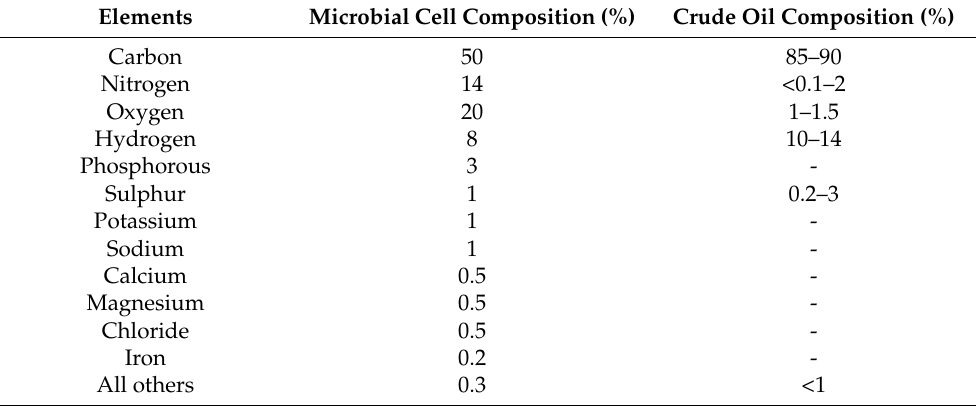
Table 3. Comparison for elemental composition of a microbial cell with petroleum crude oil